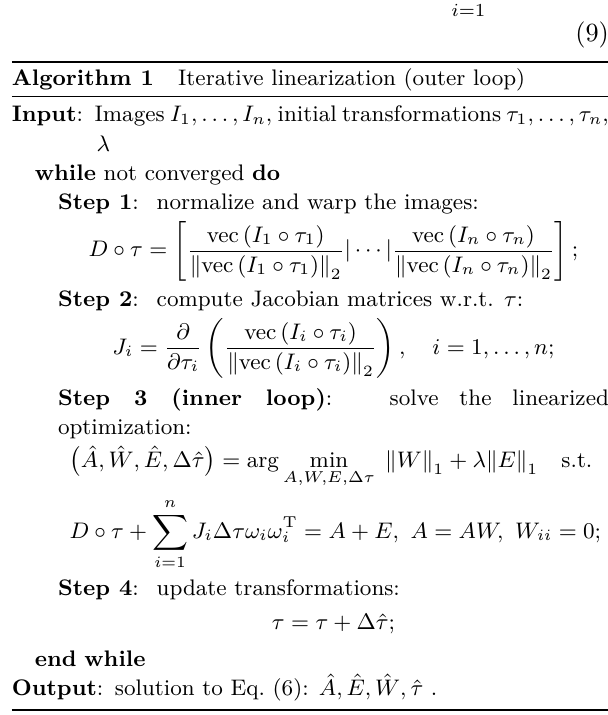
Algorithm 1 Iterative linearization (outer